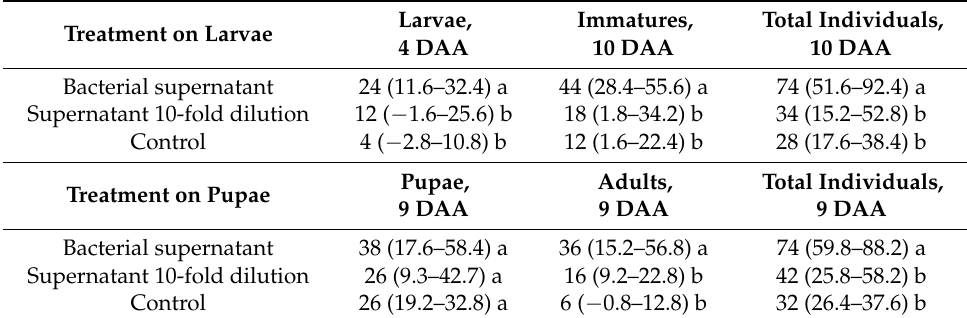
Table 2. Mortality of Drosophila suzukii larvae, pupae and adults following treatment with Photorhabdus luminescens supernatant at 3rd instar larvae or pupae stages.